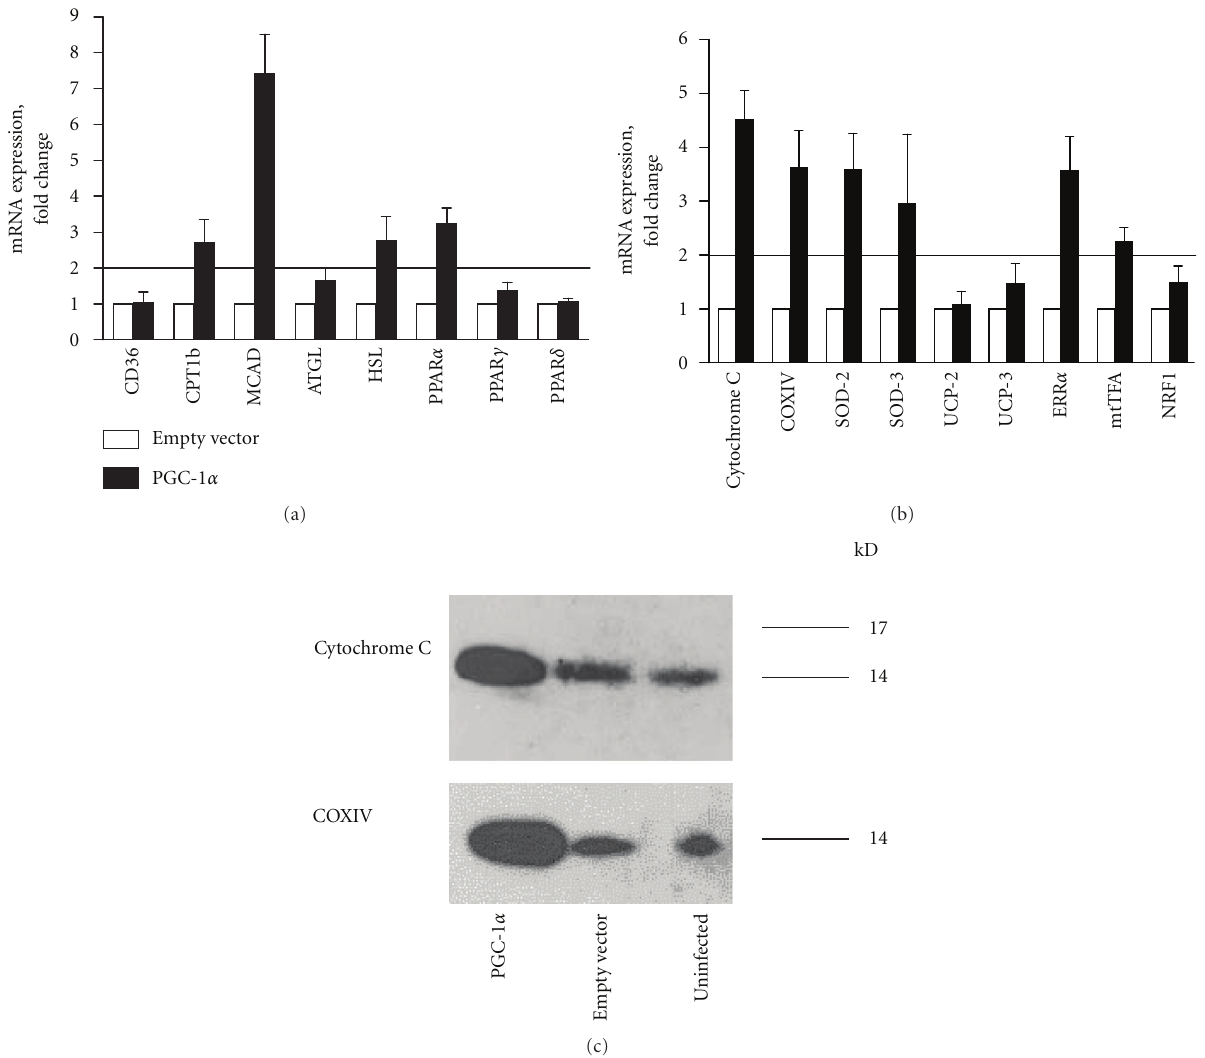
Figure 4: E ff ects of PGC-1 α overexpression on mRNA expression of genes involved in lipid metabolism (a), mitochondrial function and biogenesis (b) and on protein levels of mitochondrial components cytochrome C and COXIV (c). (a) and (b): mRNA was isolated from cultured myotubes infected with either empty control or PGC-1 α eight days after the onset of the di ff erentiation. Expression was assessed by RT-PCR as described in Section 2, and values are presented as means ± SEM of 3 experiments, each representing one donor, with 3 replicates each, normalized to levels of the housekeeping gene 36B4. A fold change ≥ 2 or ≤ 0.5 was considered an increase or decrease in expression level, respectively. (c): Aliquotes from total cell lysates were electrophoretically separated and immunoblotted with specific antibodies as described in Section 2. Images represent a single